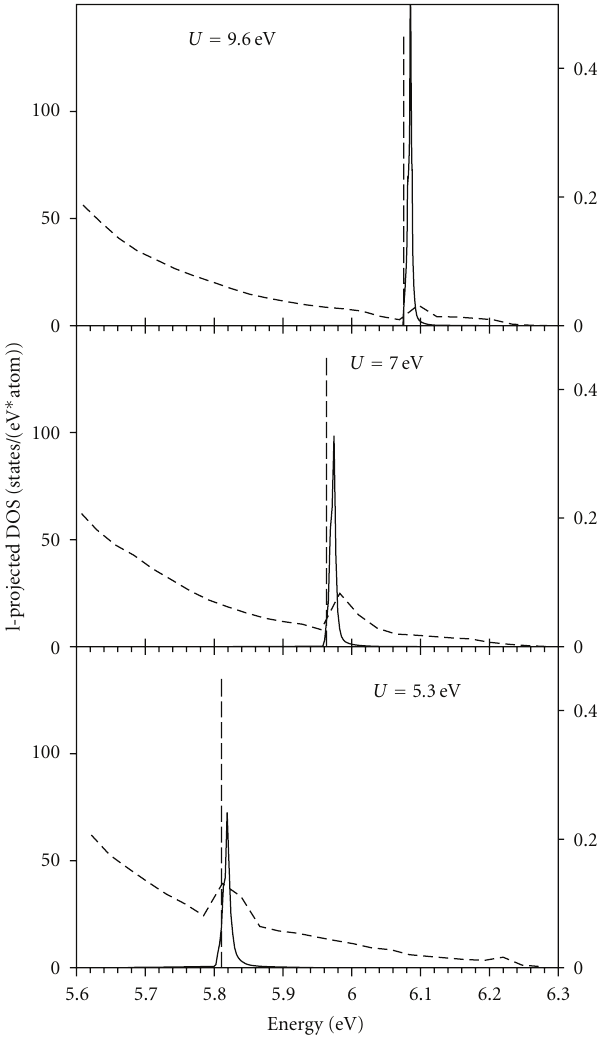
Figure 79: Yb 4 f partial DOS and As 4 p partial DOS of Yb 4 As 3 on an expanded energy scale around the Fermi level (dashed vertical [423]. The left ordinate scale is for line) for various values of U (3+) e ff the f DOS and the right one for the p DOS.